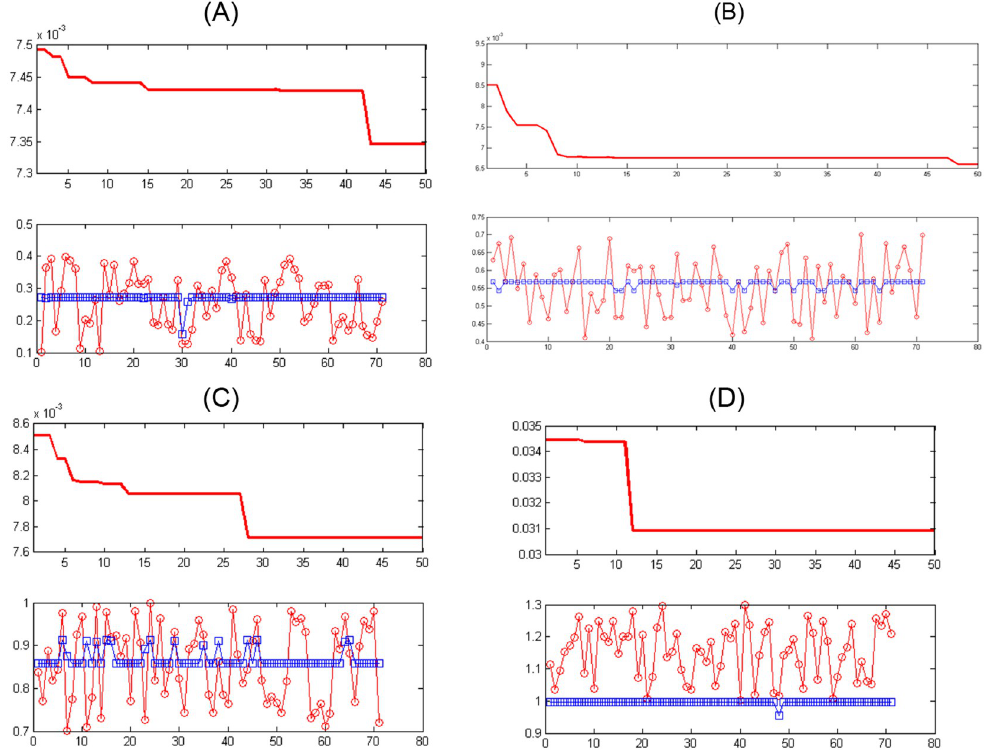
Fig 3. Convergence of the answers of the objective function obtained and the distance of the obtained answer (blue chart) in each generation change in ANN-BTA compared to the real answer (red chart) in training samples with ANN-BTA: